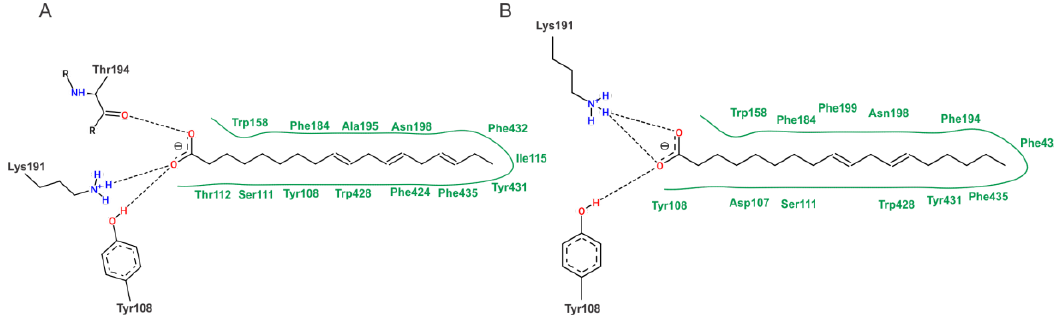
Figure 9. 2D representation of the interactions of H1 histamine receptor residues with linolenic ( A ) and linoleic acids ( B ). Dashed line—represent hydrogen bonds; green lines—van der Waals interactions.